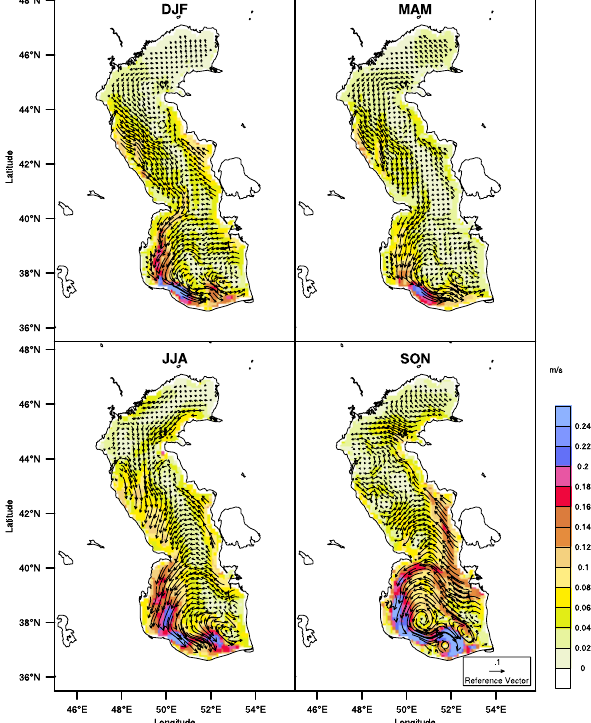
Fig. 12. Seasonal sea surface currents climatology of